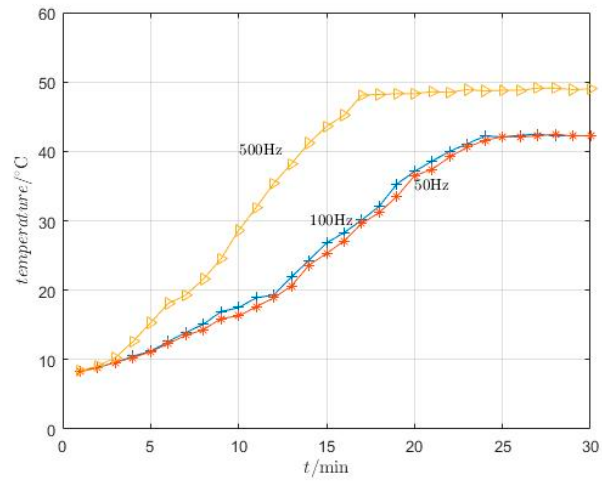
Figure 14. Temperature experiment of SGMA.